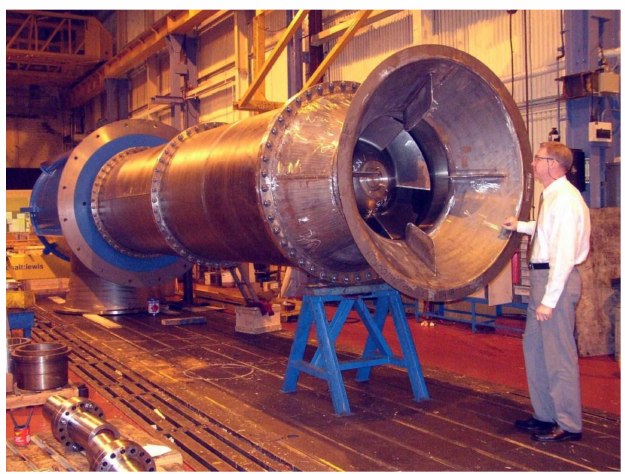
Figure 6. Large superduplex seawater pump to handle high suspended solids